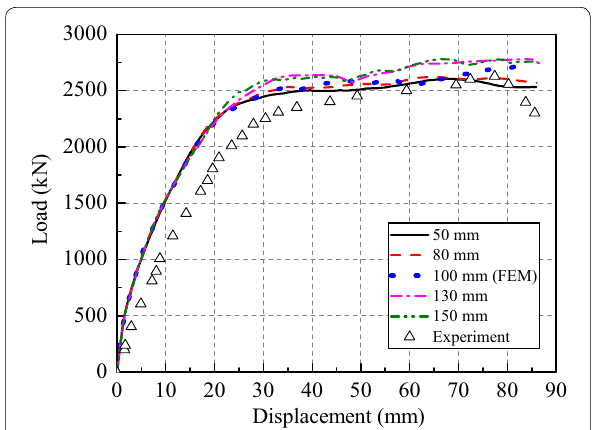
Fig. 18 Influence of the mesh size on the load vs. displacement curves.